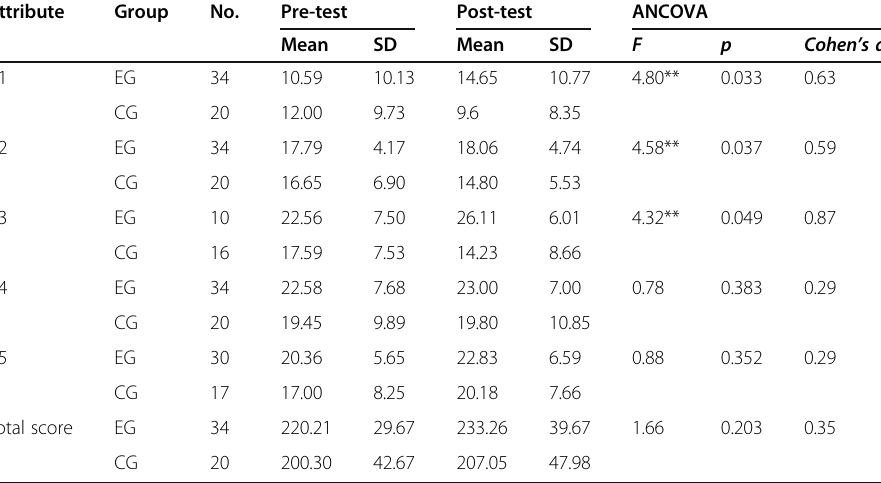
Table 6 Pre-test, post-test, and ANCOVA results for the experimental and control groups Attribute Group No.